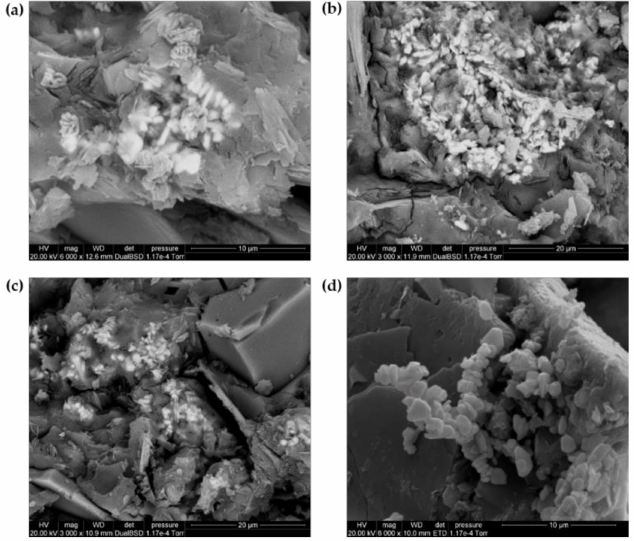
Figure 13. Selected ESEM images of magnetic particles aggregate in G2anis_6 ( a ), G2anisM_6 ( b ), G2is_6 ( c ) and G2isM_6 ( d